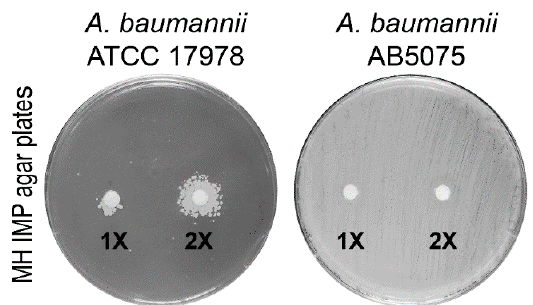
Figure 2. Microbiological plate assay showing the growth of the imipenem (IMP)-susceptible A. baumannii ATCC 17978 strain in the nearby of a disk soaked with periplasmic proteins from strain AB5075. The microbiological disks applied on the surface of the seeded plates contained 15 µL of 1 × (20 µg/mL) or 2 × (40 µg/mL) periplasmic fractions extracted using the sucrose and lysozyme method. The plates seeded with strain AB5075 served as the positive control, whereas disks containing 15 µL of the buffers used to extract periplasmic proteins were used as the negative controls (not shown). 2.3. General Features and Di ff erentially Expressed Periplasmic Proteins of A. baumannii AB5075 Grown in